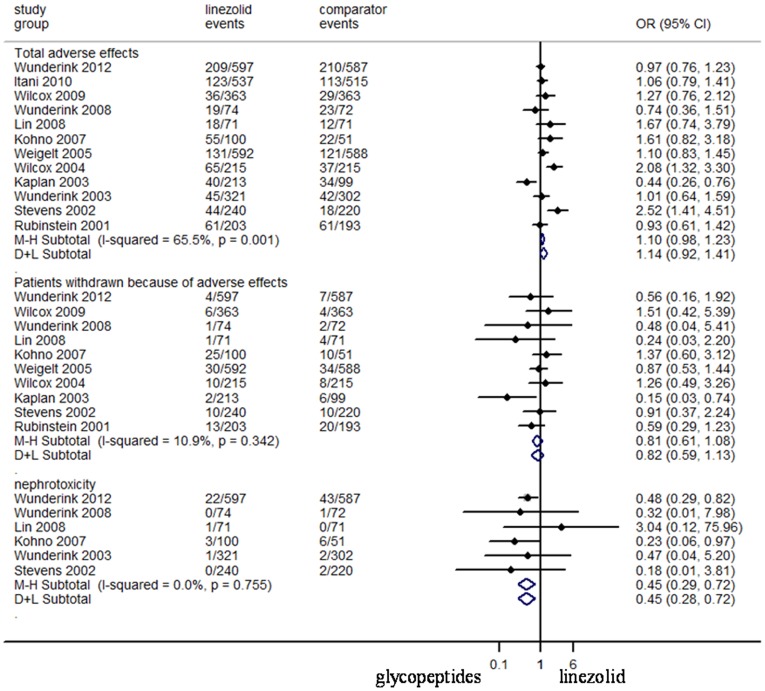
Meta-analyses of adverse effects related to studied regimens.Test of total adverse effects for overall effect: Z = 1.58 P = 0.113; test of patients withdrawn because of adverse effects for overall effect: Z = 1.41 P = 0.159; test of nephrotoxicity for overall effect: Z = 3.36 P = 0.001.